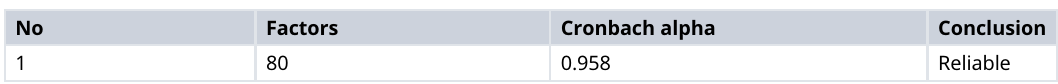
Table 3. Reliability test